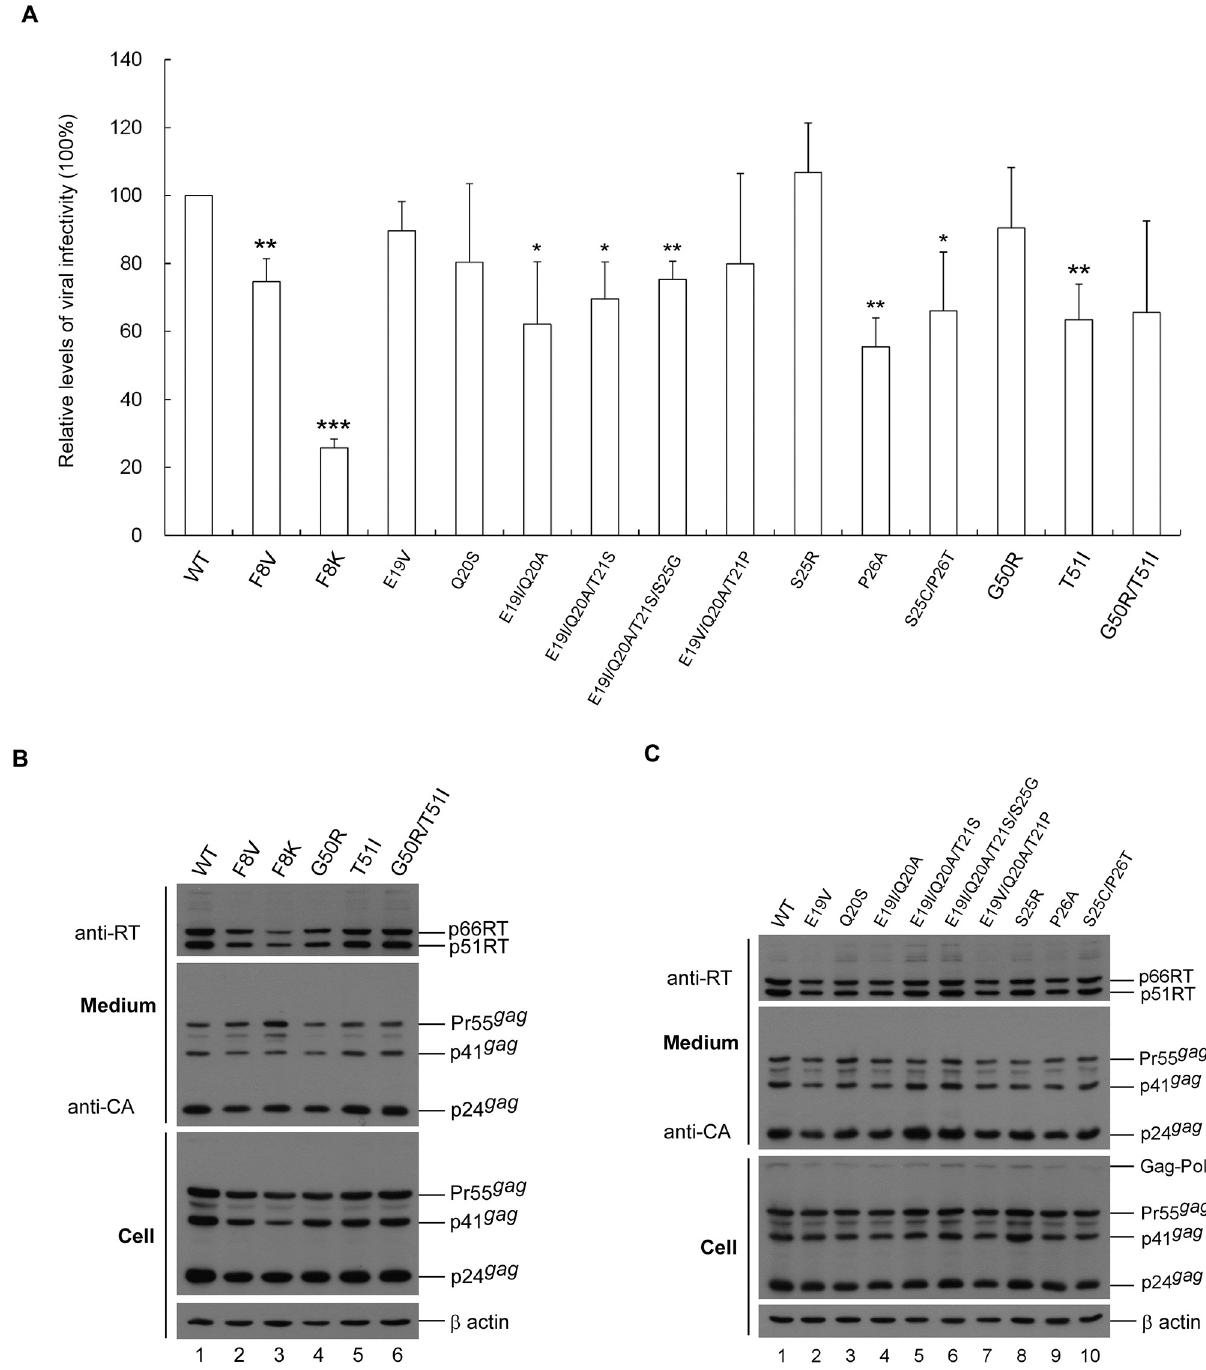
Fig 2. Effects of p6 � mutations on virus particle processing and infectivity. HEK293T cells were transfected with a wt HIVgpt or designated p6 � mutant construct plus a VSV-G expression vector. Cells and supernatants were collected 48 h post-transfection. Collected and filtered supernatant aliquots were used to infect HeLa cells. Remaining supernatants were used for immunoblot. (A) Relative virus infectivity. Drug-resistant colony infection and selection was performed as described in Materials and Methods section. Mutant infectivity was determined as the ratio of mutant titers to wt titers, normalized to Gag protein levels in parallel experiments. � p < 0.05; �� p < 0.05; ��� p < 0.001. All results are from three independent experiments. (B-C) Shown is a representative immunoblot. Membrane-bound proteins were initially probed with anti-RT serum prior to stripping and probing with an anti-p24CA monoclonal antibody. HIV-1 Gag-Pol, Pol, 66/51RT, Pr55 gag , p41 gag and p24 gag positions are shown.